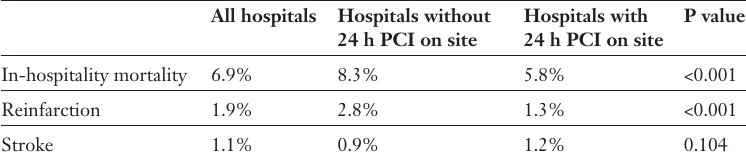
Patients outcome.